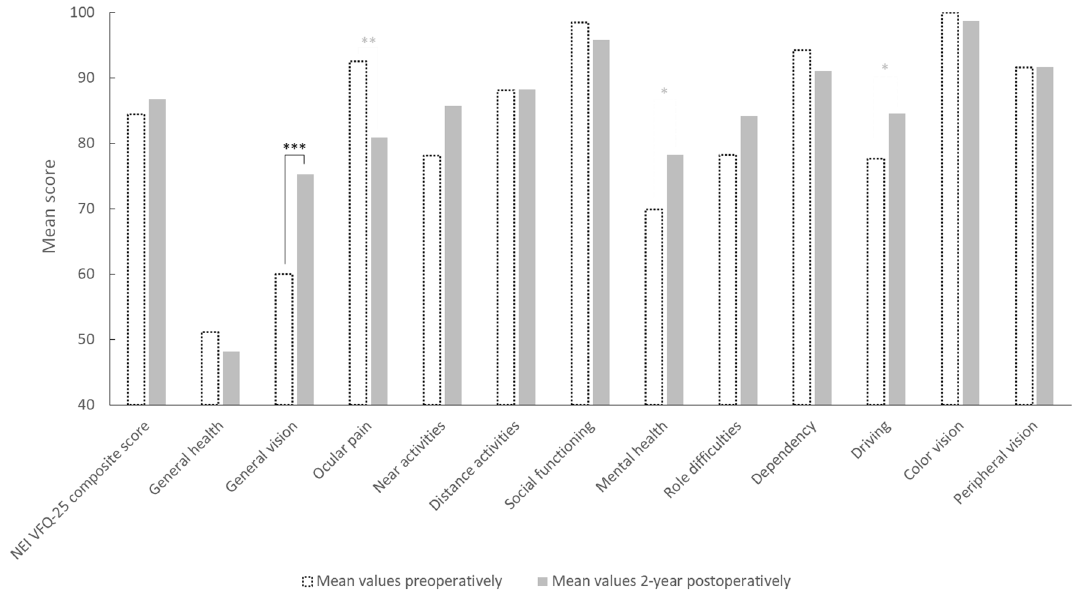
Figure 2. Evolution of the mean values of each sub-category and the composite score of the NEI VFQ-25 preoperatively and 2-year postoperatively. * p value < 0.05; ** p value < 0.01; *** p value <